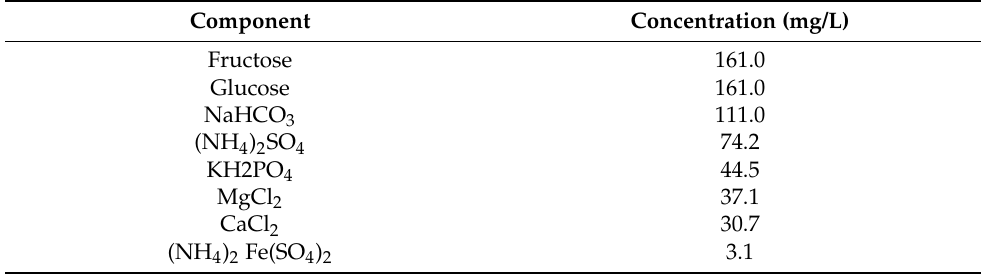
Table 1. Composition of the synthetic wastewater.